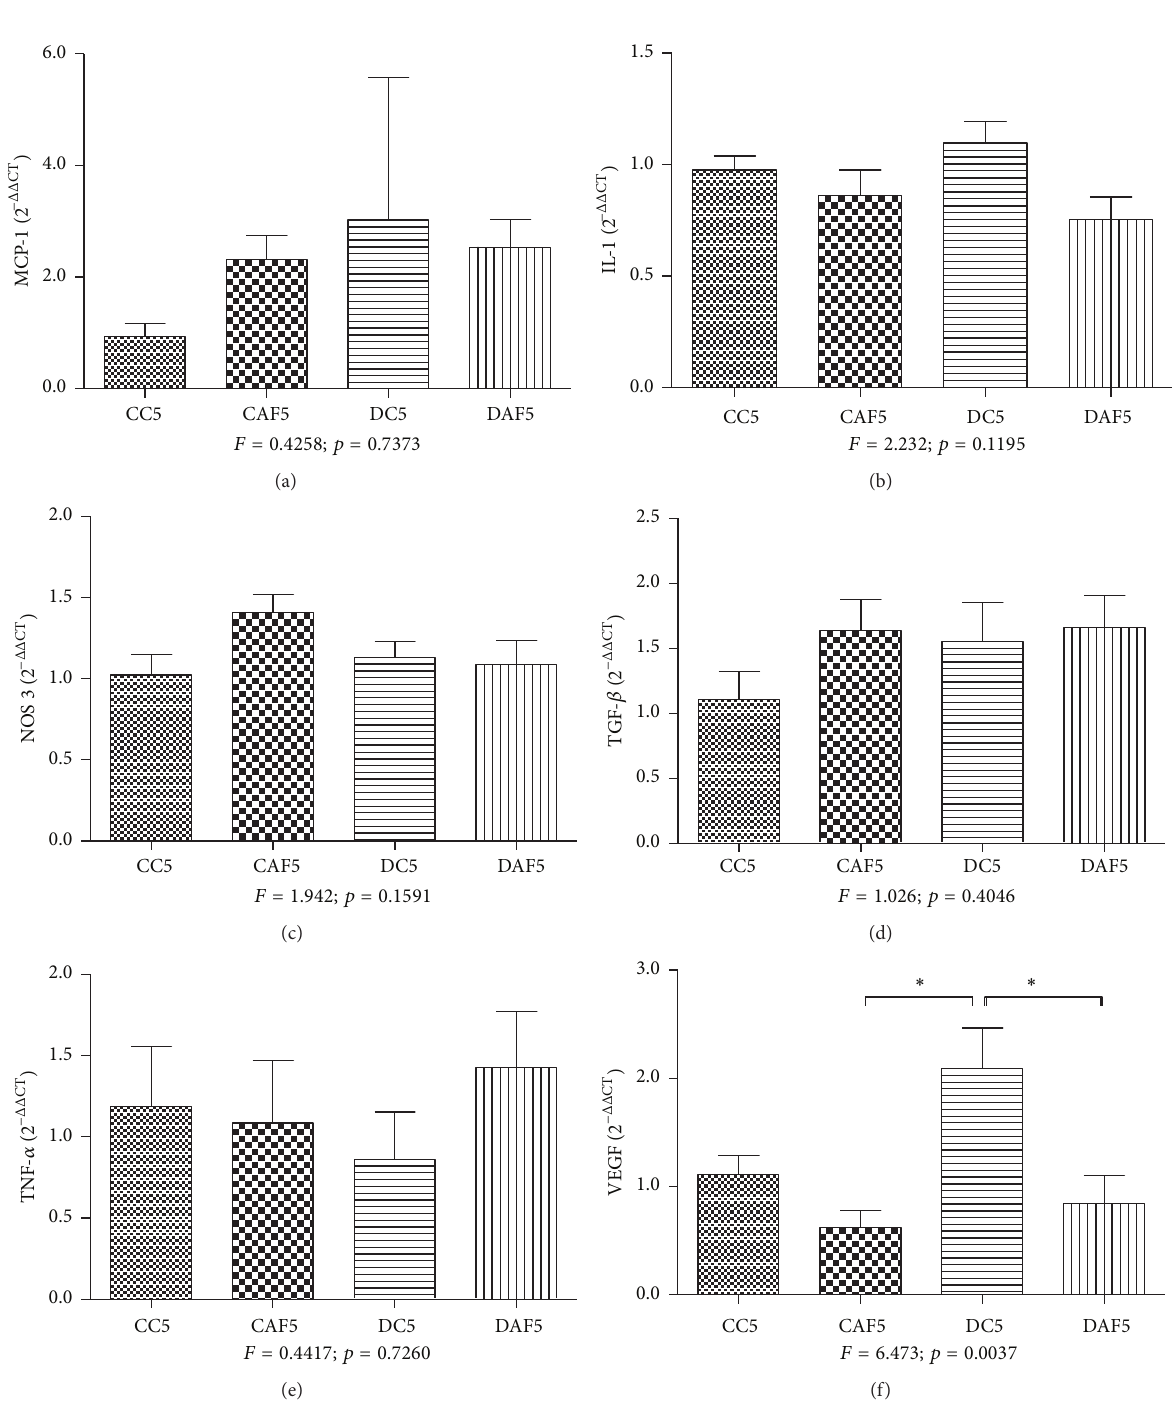
Figure 4: mRNA gene expression of MCP-1, IL-1, NOS3, TGF- 𝛽 , TNF- 𝛼 , and VEGF in the kidney of control offspring and diabetic offspring with or without folic acid, aged five months. (a, b, c, d, and e) The gene expression of MCP-1, IL-1, NOS3, TGF- 𝛽 , and TNF- 𝛼 showed no significant difference between the study groups; (f) the gene expression of VEGF was decreased in the CFA5 and DFA5 groups. ∗ Significant